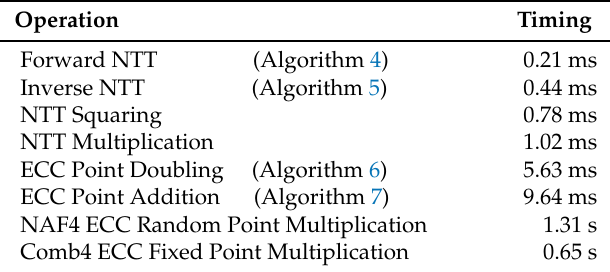
Table 1. Our timings for GF (( 2 13 − 1 ) 13 ) arithmetic and ECC operations on MSP430F1611 @ 8 MHz.